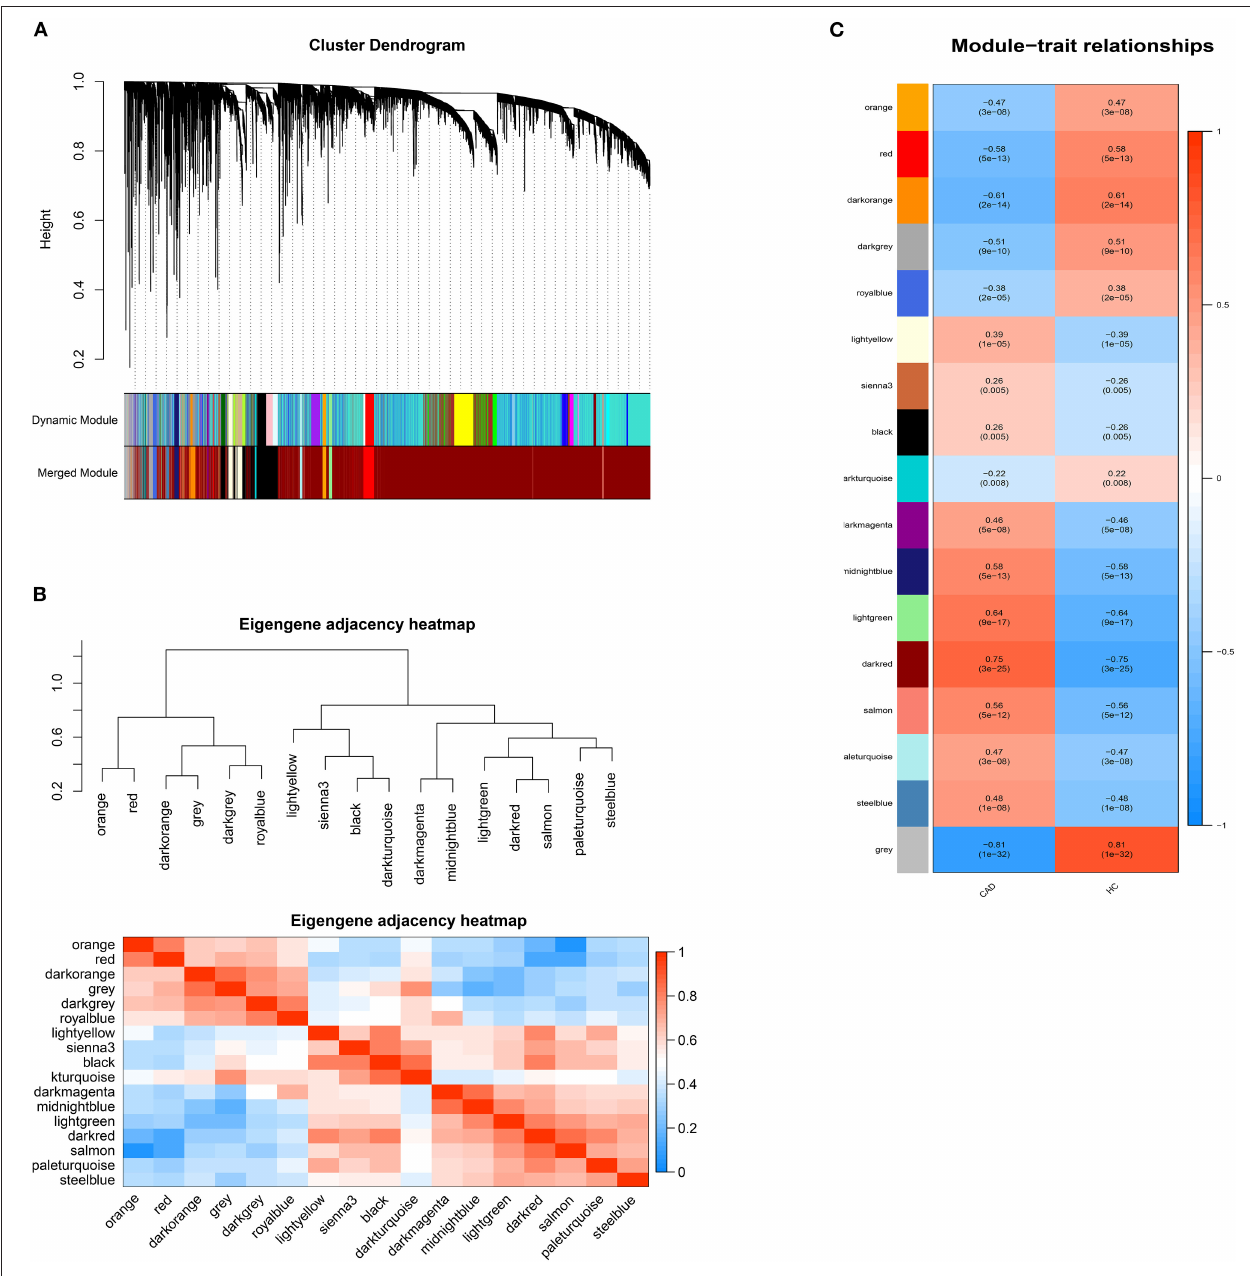
FIGURE 2 | Weighted genes correlation network analysis. (A) The dendrogram of differentially expressed lncRNAs. (B) The heatmap of module-trait correlations. Blue represents negative correlation, and red represents positive correlation. (C) The clustering heatmap between modules. Red means closer similarity, and blue means farther